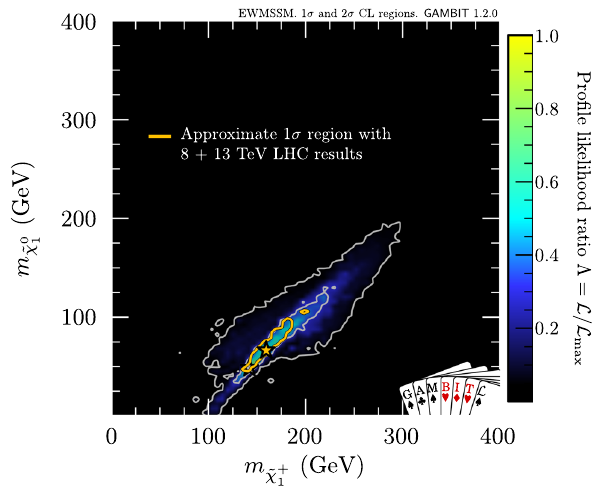
, m ) planeofthemainfit,with Fig. 19 Profile likelihoodinthe ( m ˜ χ ± ˜ χ 0 1 1 approximate 1 σ contour after also applying 8TeV searches overlaid in orange. White contour lines show the 1 σ and 2 σ confidence regions of the main fit. The best-fit point based on 8 + 13TeV data is marked by the orange star, and the 13Tev-only point (partially obscured by the orange contour) is marked with a white star Table 9 Parameter values and sparticle masses for new benchmark points obtained after applying 8TeV searches to the region preferred at 1 σ by 13TeV searches. The first point (#5) is the new best-fit model, for which the Higgsinos are heavier than the winos. The second point (#6) is the new best-fitting solution to have winos heavier than the Higgsinos